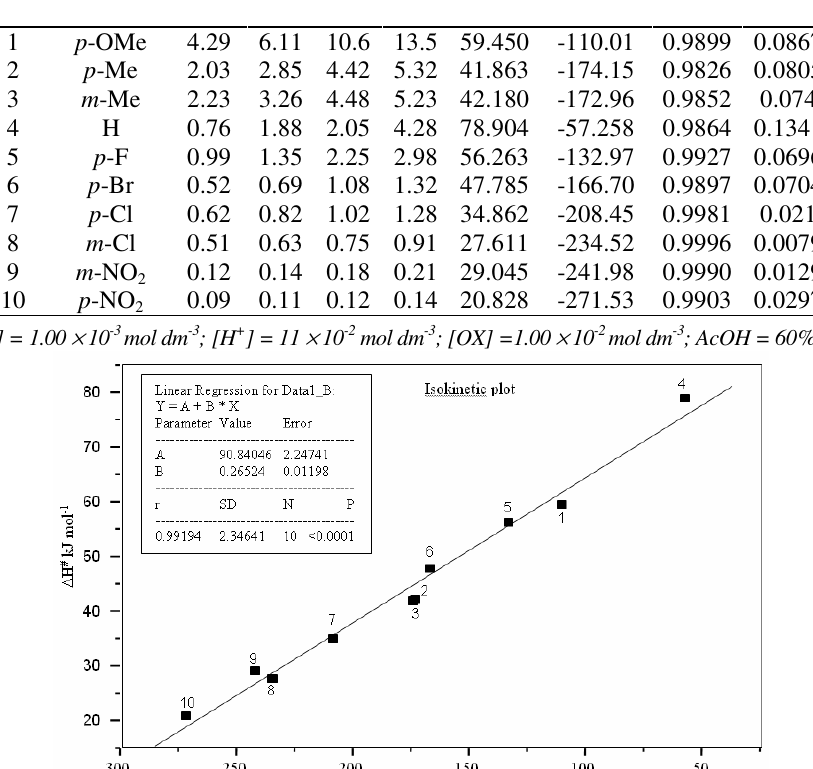
Figure 1. The plot of ∆ H # versus ∆ S # .